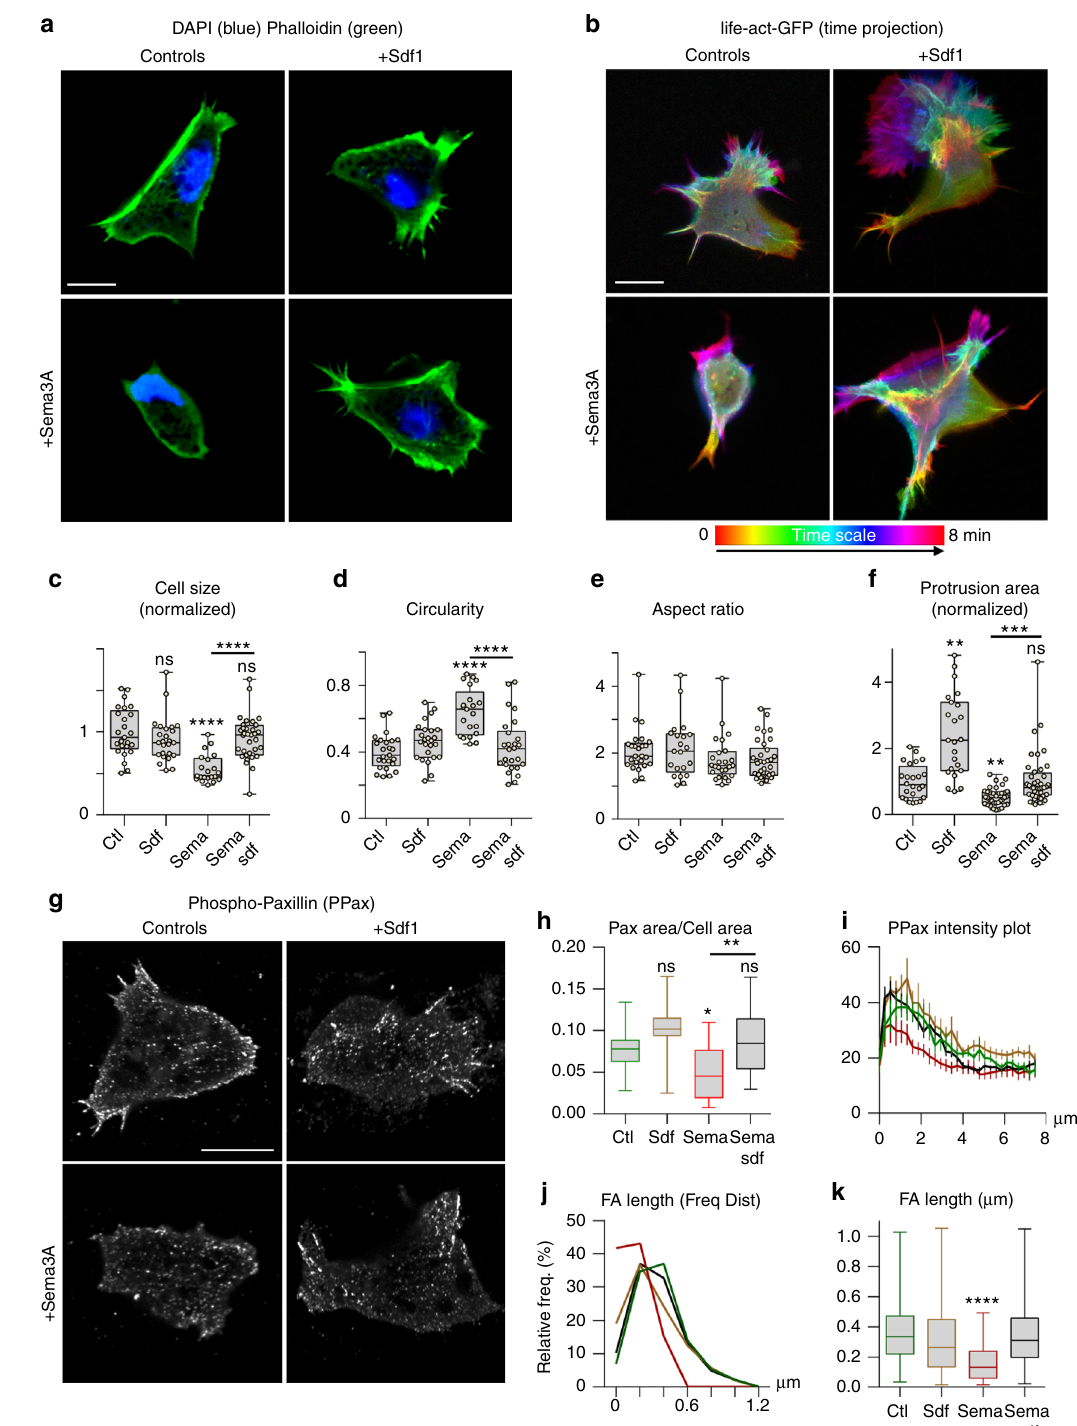
looked at Focal Adhesions (FAs). We fi rst let cells adhere to Fibronectin before adding Sema3A and/or Sdf1 in solution 30 min before fi xation. This allowed us to assess direct effect on FAs without bias on cell area. Sdf1 and Sema3A had antagonistic effects on FAs (Fig. 4g), including the total area occupied by FAs (Fig. 4h) and their polarised distribution from the cell tip to the cell ’ s centroid (Fig. 4i). Both effects are due to a loss of large FAs (Fig. 4j, k). Importantly, adding Sdf1 restored all values to control levels. The actin cytoskeleton looked dramatically